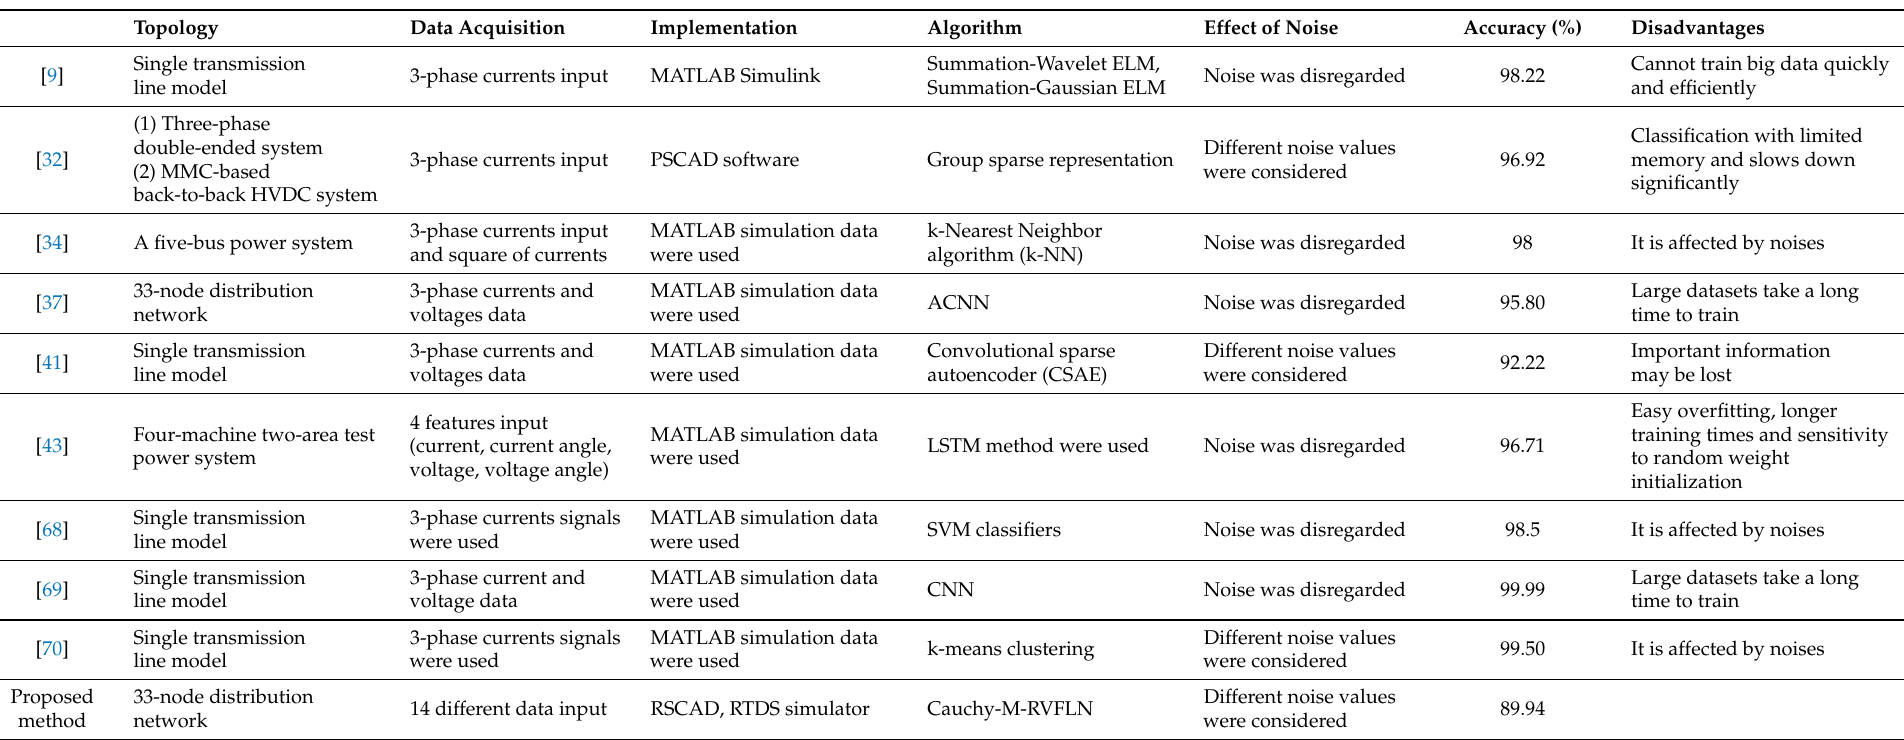
Table 6. Compared with Other Studies in the